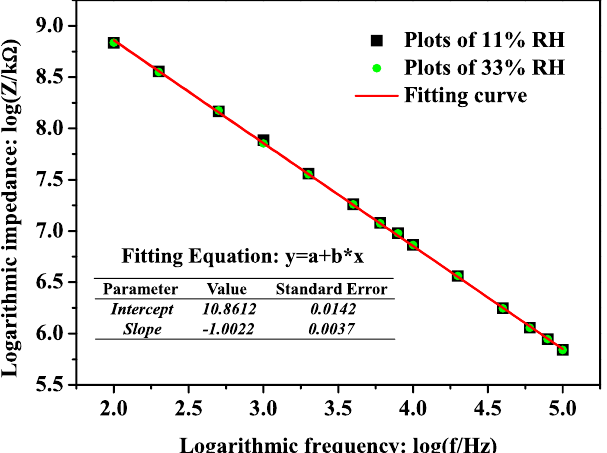
Figure 5. Linear fit plot of log Z vs. log f for Pyr-rGO at 11% and 33%